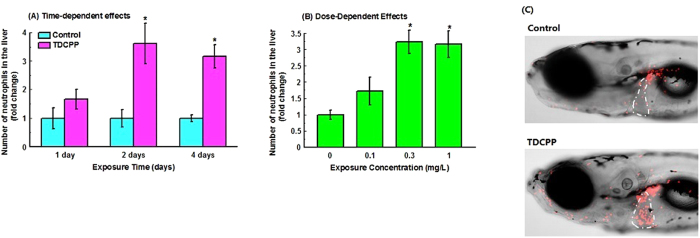
Dose- (A) and time-dependent (B) increase of neutrophils in the livers of Tg(lysC:dDsRed) zebrafish larvae in response to TDCIPP exposure.Images were captured with a digital camera attached to a Carl Zeiss LSM 510 Meta fluorescent microscope. (C) Representative images from control group and 4-day TDCIPP (1 mg/L) exposure group. The livers are outlined with white lines. Values represent mean ± SEM. Significant difference between the two groups were observed: P < 0.05.